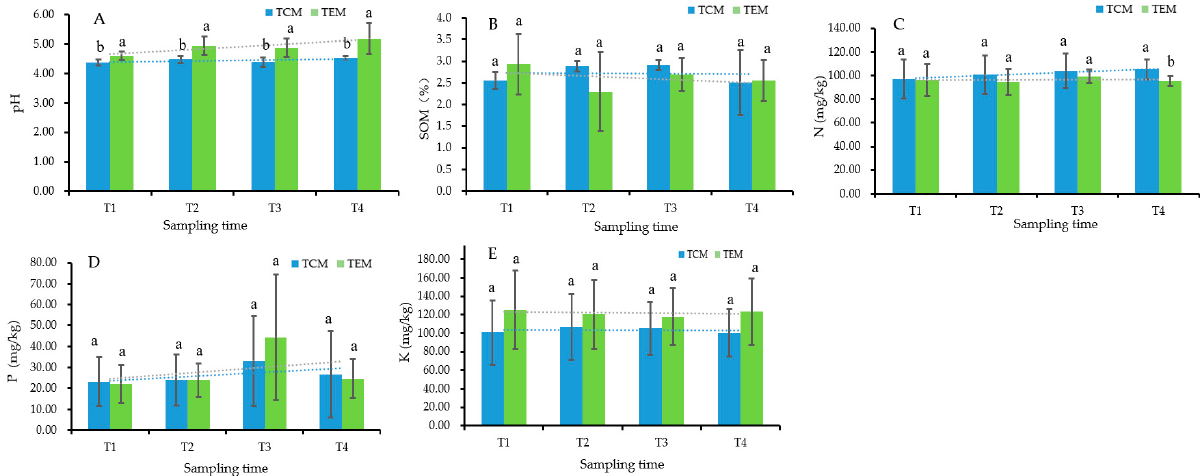
Figure 3. The effects of management mode on the soil physicochemical properties. The different letters labeled in columns are significantly different according to Duncan’s test ( p < 0.05). ( A ) pH value, ( B ) soil organic matter (SOM), ( C ) available nitrogen content (N), ( D ) available phosphorus (P) content, and ( E ) available potassium (K) level. TCM = tea conventional management; TEM = tea ecological management. T1 = winter 2015; T2 = winter 2016; T3 = winter 2017; T4 = winter 2018. Table 2. The effects of management mode on the soil physicochemical properties.